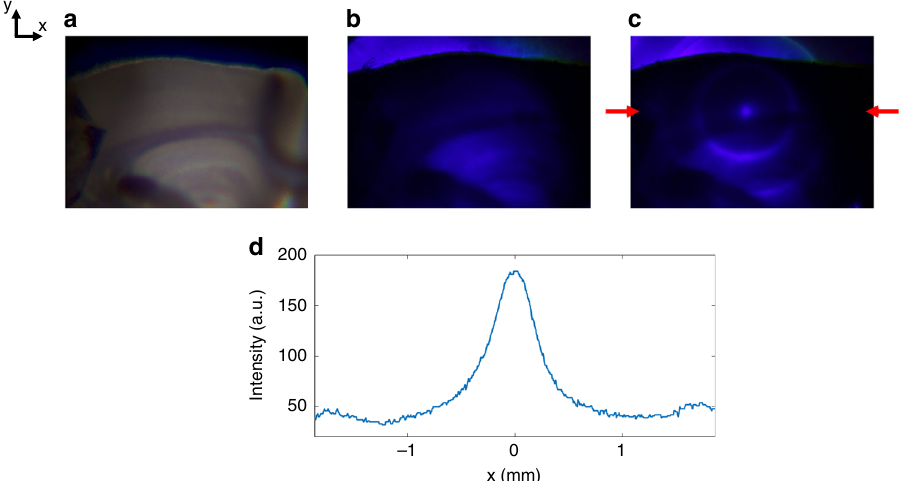
Fig. 7 Light is con fi ned within a mouse brain tissue. a Bright fi eld microscope image of a 240 µ m thick coronal brain slice from a mouse. b Blue light imaged through the brain slice tissue with no ultrasound. Laser beam is traveling along z- direction, impinging on the brain slice from the bottom and being imaged from the top, as shown in Fig. 2a. c Blue light imaged through the tissue couples to a sculpted waveguide, when ultrasound is turned on. d Line cross- section of the con fi ned optical waveguide mode through the brain slice tissue near the top edge of the slice. The line-cut is through the line indicated by the red arrows in Fig. 7c. The measured extinction ratio (ER1) is the 240 µm thick mouse brain tissue is larger than 7 ℓ s. Laser light phased array is placed around the brain slice. Using our techni-